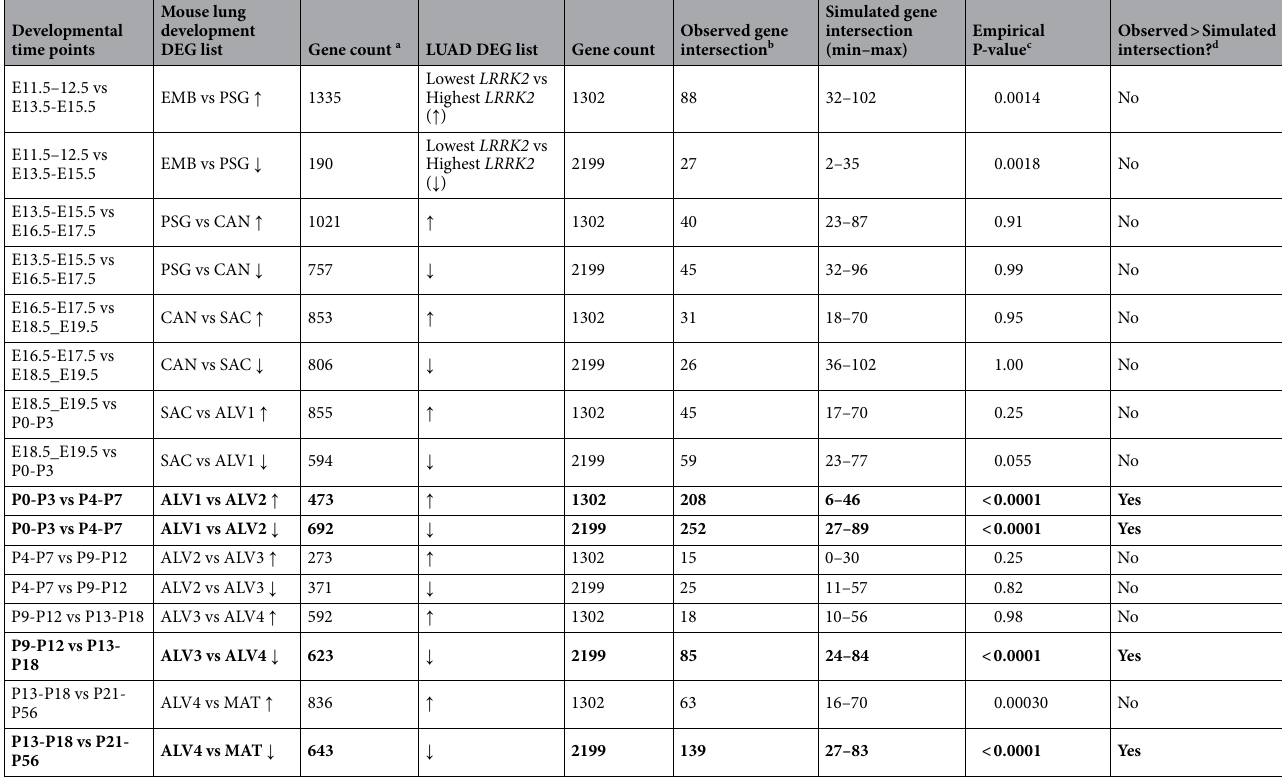
Table 1. Overlap of DEGs identified in the lowest LRRK2 -expressing TCGA LUAD tumors with DEGs identified in mouse lung development. ↑ / ↓ increased/decreased, EMB embryonic, PSG pseudoglandular, CAN canalicular, SAC saccular, ALV1-4 alveolarization stages 1–4, MAT mature lung. a Gene count is defined